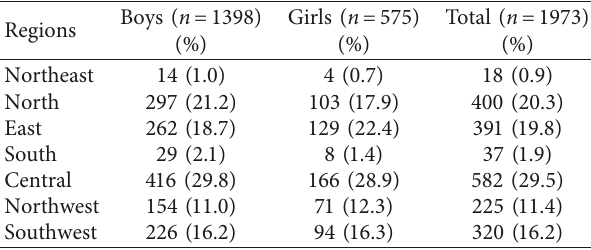
Table 1: Distribution of cases in boys and girls in different regions of China from 2019 to